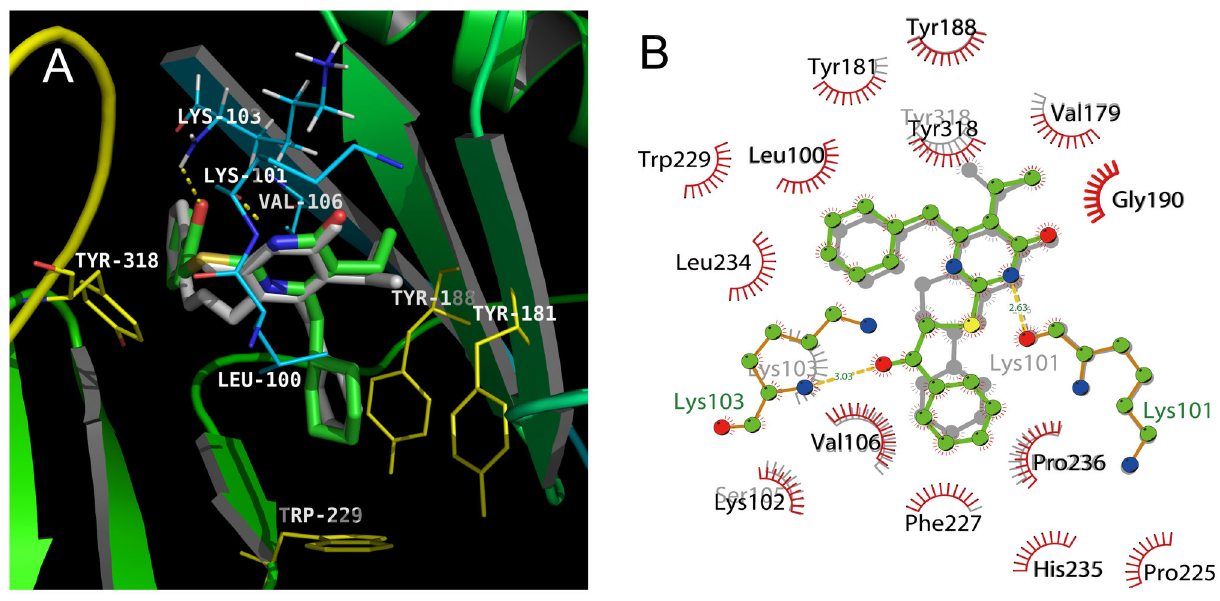
Figure 4. Molecular docking of DB-02. ( A ) Superimposition of the docked conformations of DB-02 (green-colored carbon atoms) and TNK-651 (grey). The docking results are showed by PyMOL. The backbone is represented by ribbons, and amino acid residues important for binding interactions are labeled. Dotted lines show the interactions between HIV-1 RT and DB-02. ( B ) The two- dimension representations of the interactions between the NNIBP and DB-02 (green) or TNK-651 (grey) are presented after the